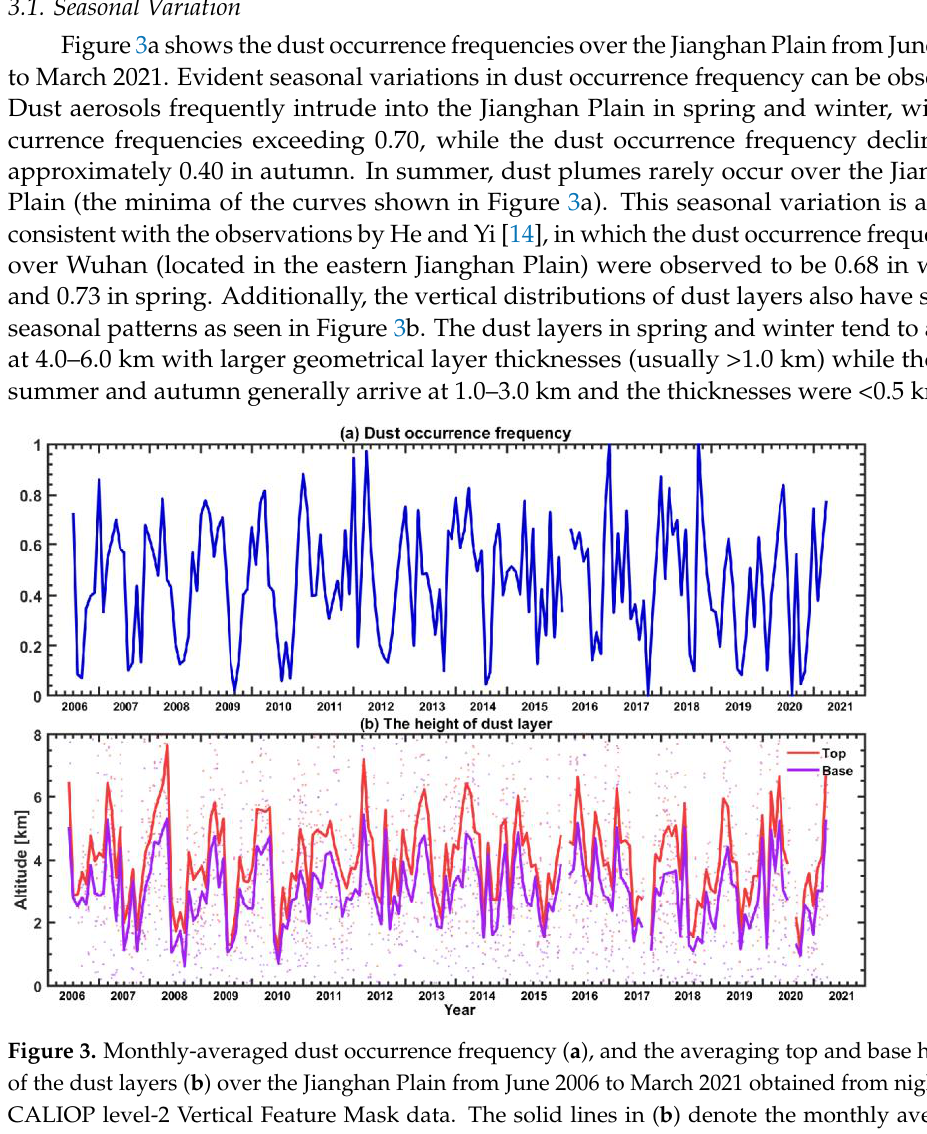
Figure 2. Flowchart of the dust extinction coefficient 𝛼 p and the mass concentration of dust 𝑀 d using the POLIPHON method.